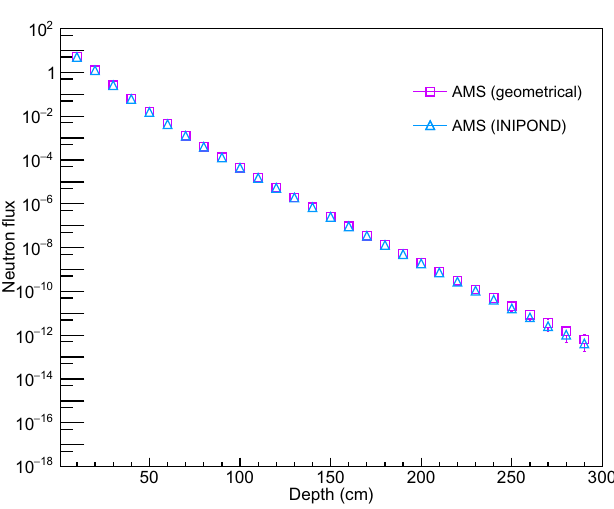
Fig. 6. Flux attenuation in the Water